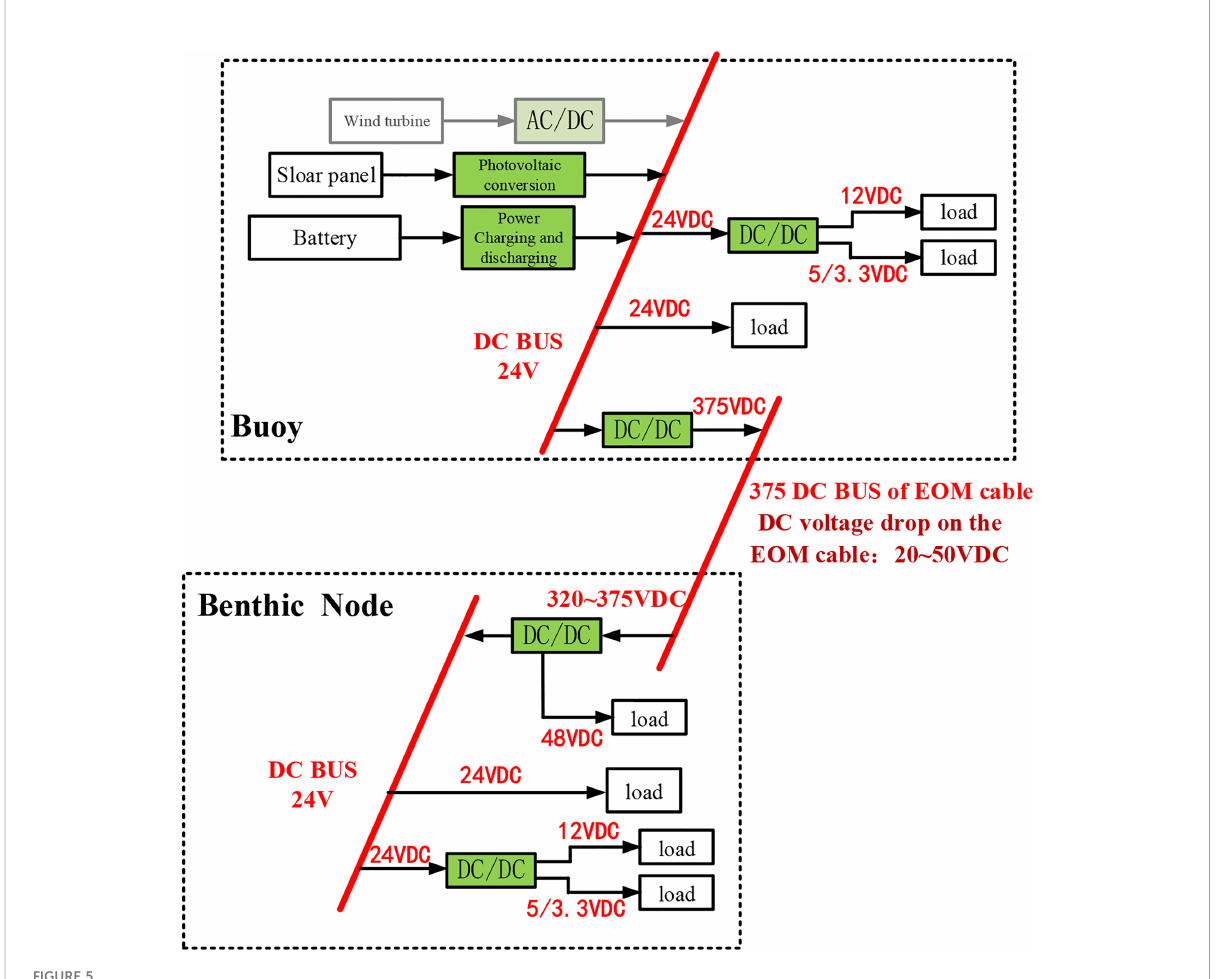
FIGURE 5 Power supply of